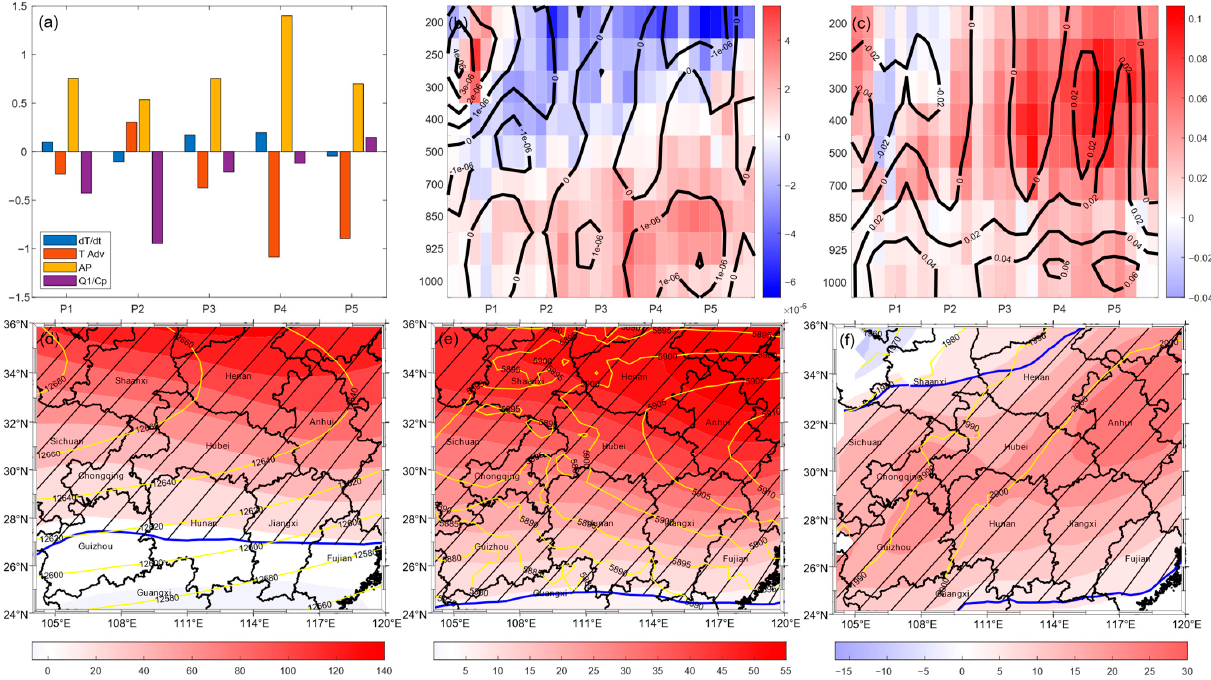
Figure 13. ( a ) The decline in temperature budget in the RMV-NSE run compared with the control run. The four columns denote temperature tendency, horizontal advection of temperature, adiabatic heating related to vertical movement, and diabatic heating, respectively (K/day). ( b ) The decline in divergence (shading; s − 1 ) with the divergence in control run (black line, smoothened with 3-by-3 kernel convolution; s − 1 ). ( c ) The decline in vertical speed (shading; Pa/s), with the black line showing the vertical speed in control run (smoothened with 3-by-3 kernel convolution; Pa s − 1 ). ( d – f ) The decline in geopotential height (shading; gpm), with the yellow line showing the geopotential height in control run (smoothened with 3-by-3 kernel convolution; Pa/s) at ( d ) 200 hPa, ( e ) 500 hPa, and ( f ) 800 hPa. Slash hatches and blue lines denote areas that passed the 99% significant test.